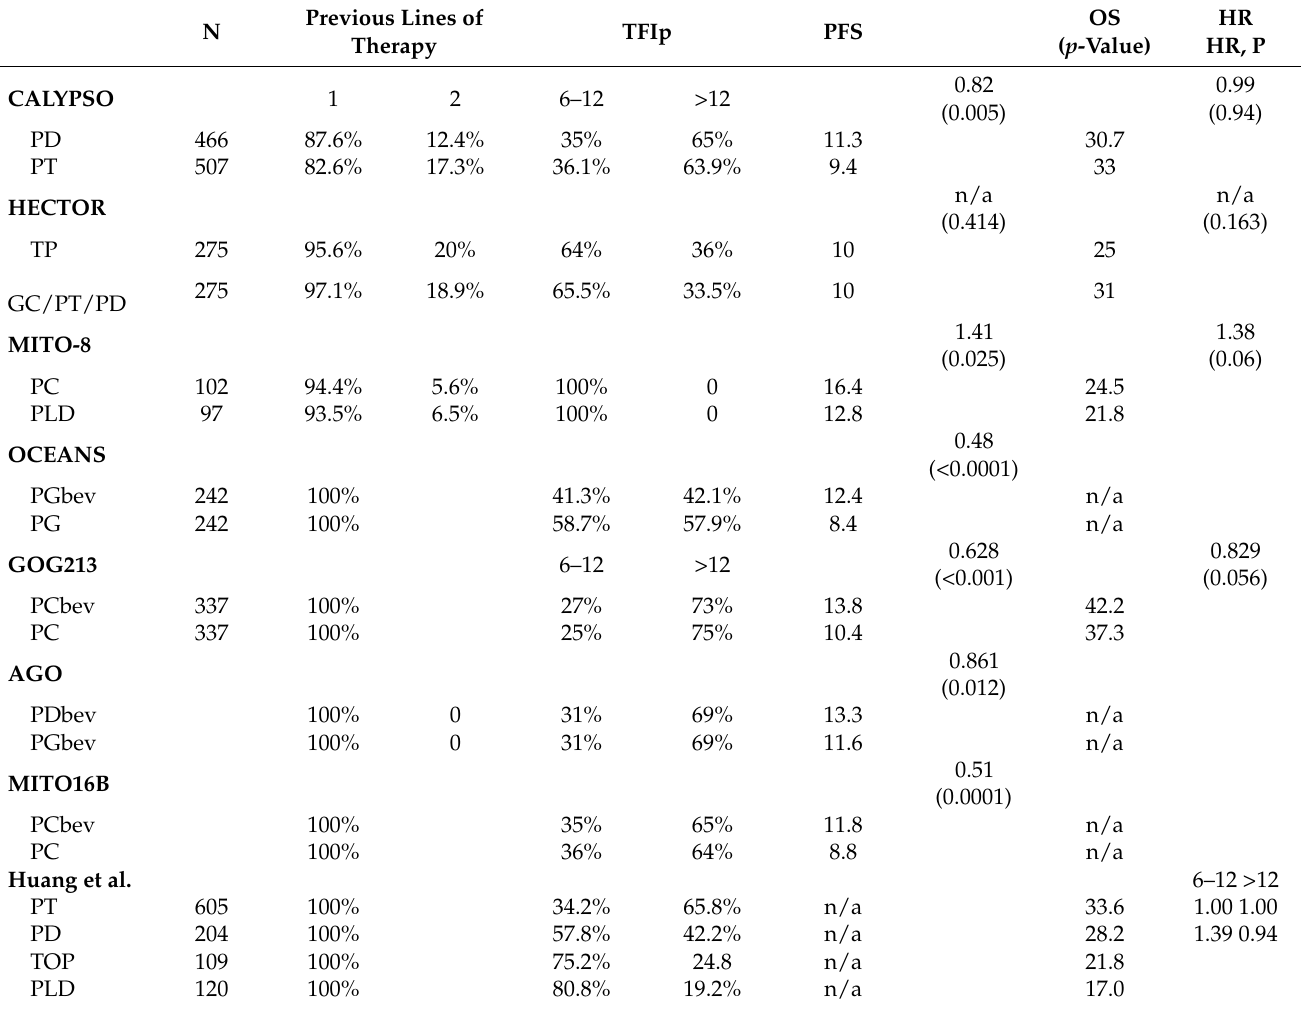
Table 2. Comparison of the different trials of PSROC and our current